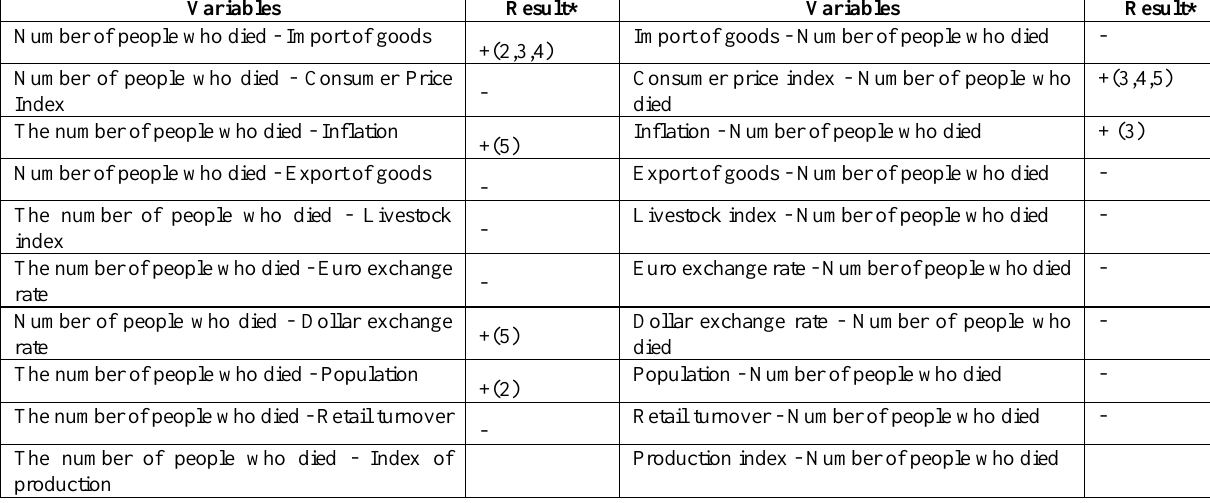
Table 2 (cont.). Results of applying the Granger